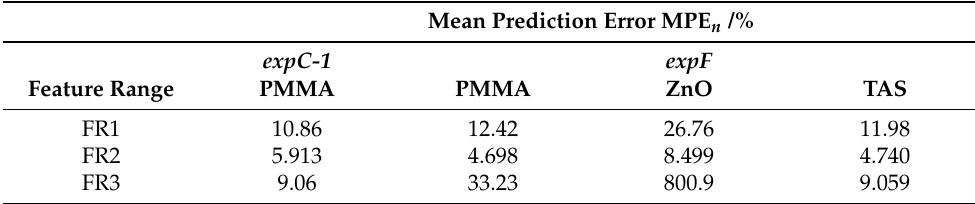
Table 2. Prediction error for the solids volume fraction φ specified for each material (PMMA, ZnO) as well as the combined amount of suspended solids (TAS) excluding the mass of stabilizing agent Na6P6O18. The row related to the chosen feature range FR2 has the lowest